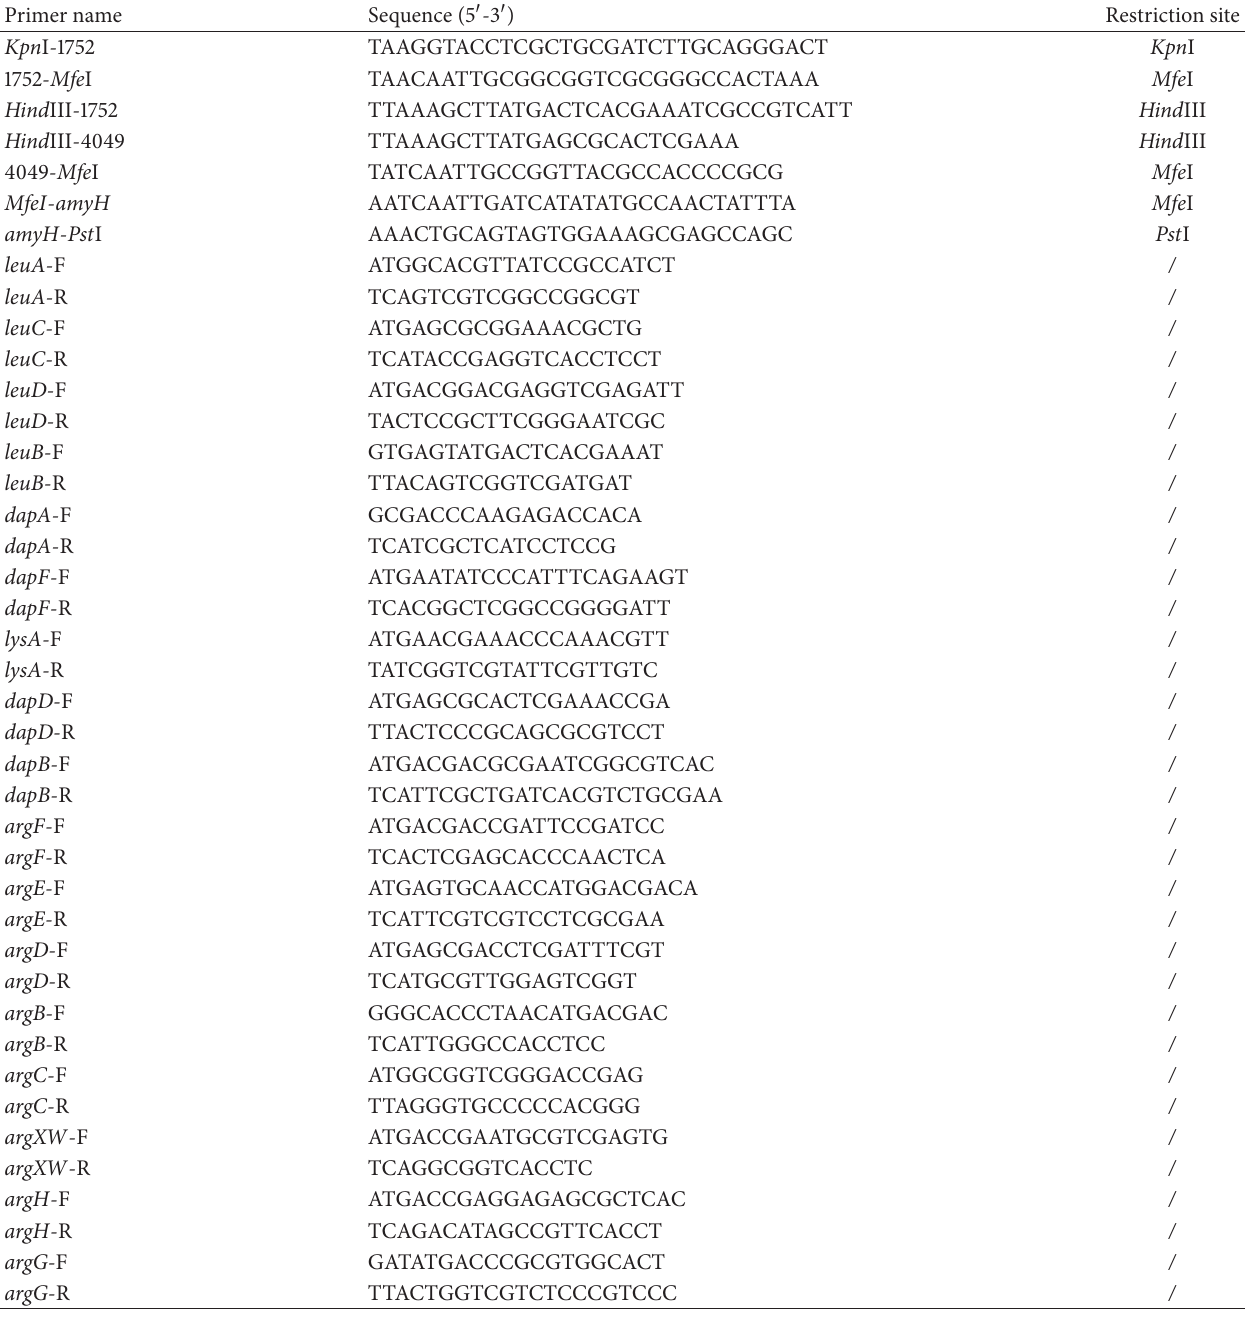
Table 2: Primers used in this